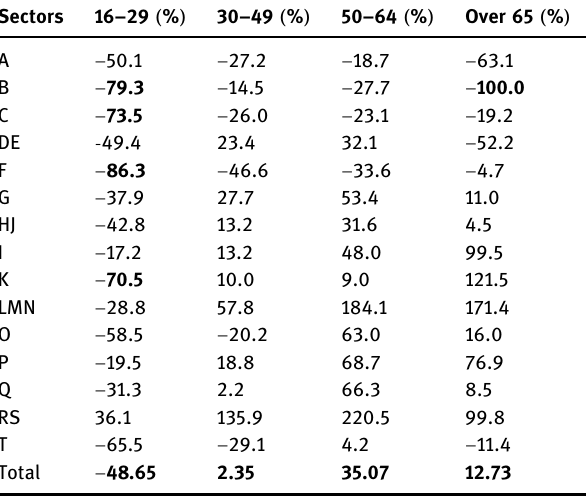
Table 3: Variation in employment by age and productive sector during the 2005 – 2015 period